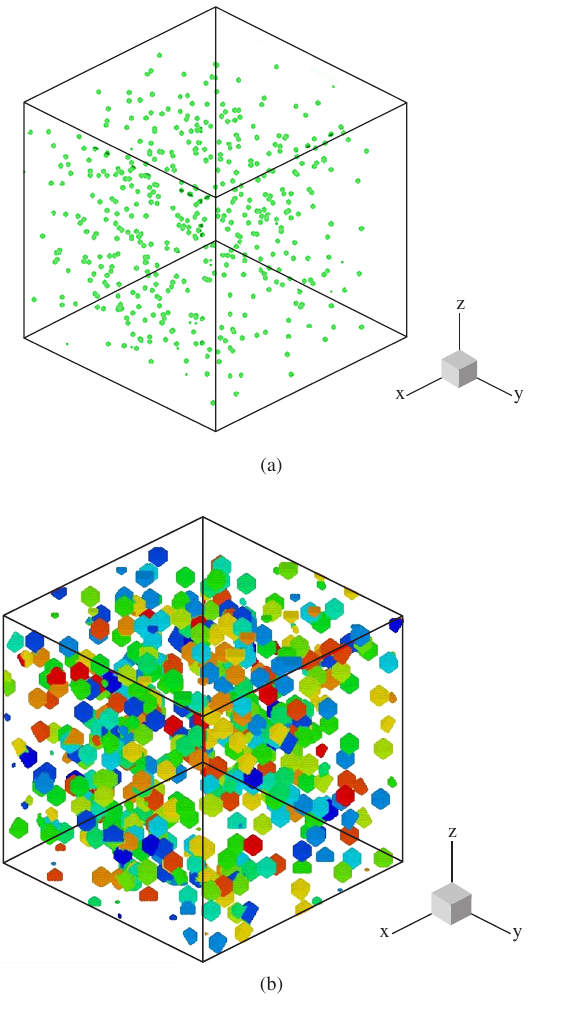
Figure 2. Simulated microstructure for clustered nuclei, 64 boxes were ran- domly chosen from 4096 boxes and 64 nuclei were randomly located within each box: a) t = 0; and b) at volume fraction equal to 0.1 nuclei within clusters have already impinged. Only part of the 304 x 304 x 304 matrix is shown to avoid overloading the